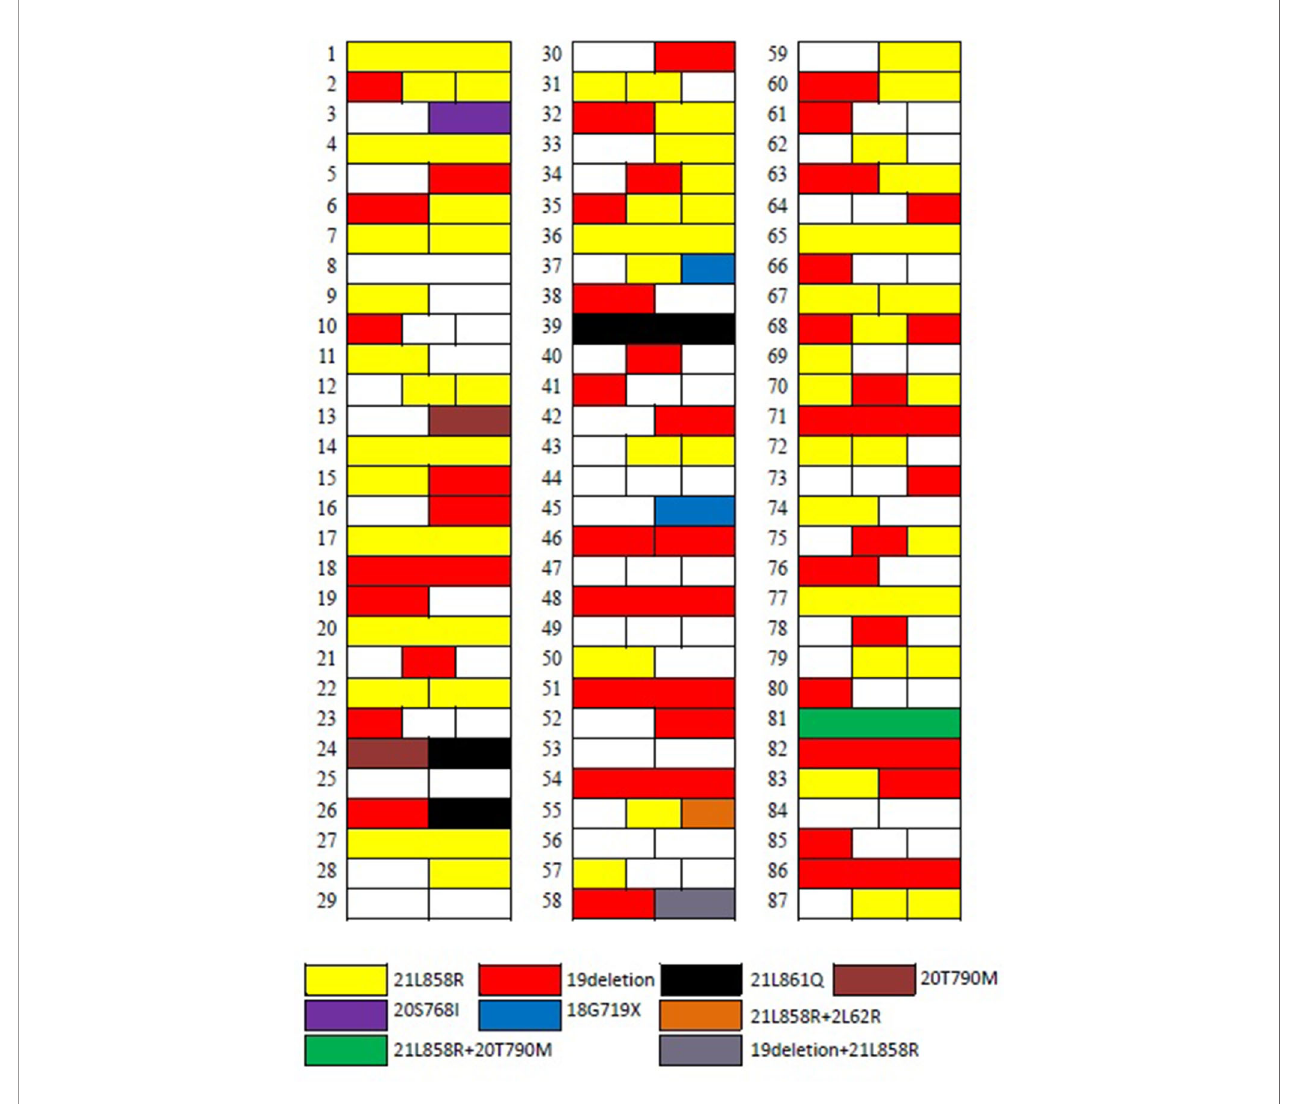
FIGURE 2 | The distribution of EGFR mutations in 87